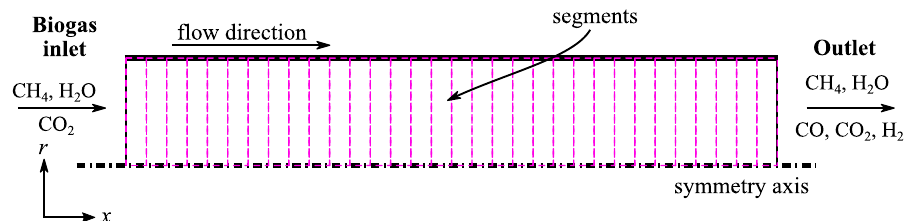
Figure 1. Domain defined for a biogas reforming